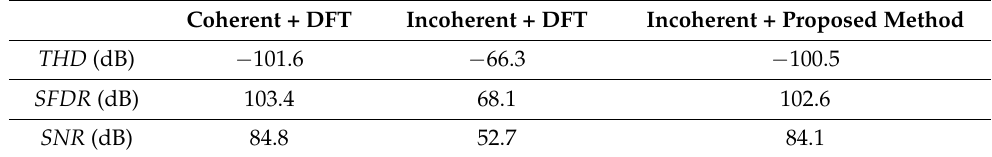
Table 1. The THD , SFDR , and SNR values obtained under coherent and incoherent sampling, β = 0.4. Coherent + DFT Incoherent + DFT Incoherent + Proposed